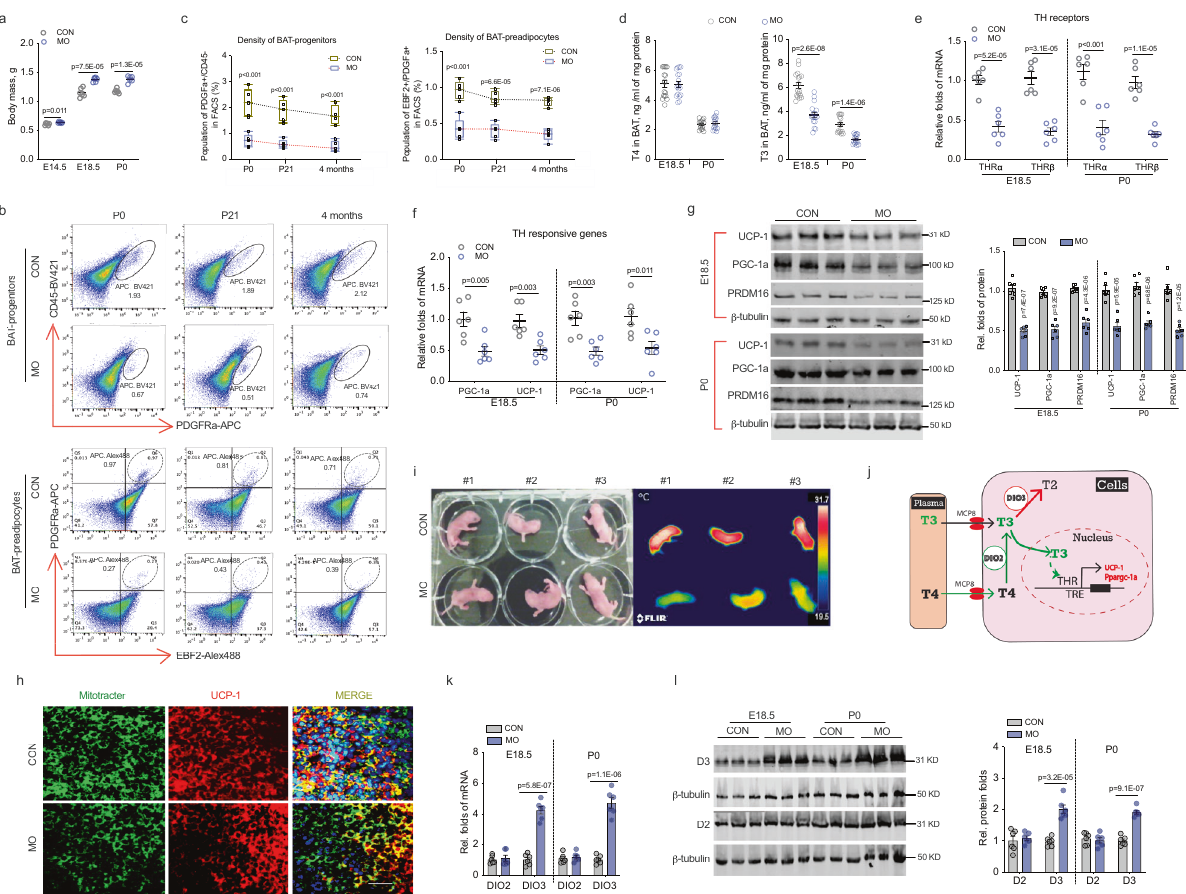
Fig. 3 Maternal obesity (MO) reduces T3 concentration and thyroid hormone signaling, linking to impaired brown adipogenesis with a fetal origin. a Fetal mass in control and obesity dam (MO) at 22 °C ( n = 6). b Density of brown progenitors (solid circle) and preadipocytes (dash circle) in female offspring BAT at P0, 21 days (weaning), and 4 months of age. FACS sorted brown progenitors and preadipocytes in BAT-stromal vascular fractions using brown progenitor marker Lin: CD45 − /PDGFRa + (in black solid circle) and brown preadipocyte marker Lin: EBF2 + /PDGFRa + (dash black circle in right side quarter). c Quanti fi ed brown progenitors and preadipocytes in BAT of female offspring ( n = 5). Whisker of box plots shows means and individual values from minimum to maximum. d Thyroid hormone (TH) thyroxine (T4) and triiodothyronine (T3) concentrations were analyzed in fetal and neonatal BAT at embryonic days E18.5 ( n = 15) and P0 ( n = 17). e , f mRNA expression of TH receptors TR α and TR β ( e ), and TH responsive genes Ppargc1a and Ucp- 1 ( f ) in fetal and neonatal BAT at E18.5 and P0 ( n = 6). mRNA expression was normalized to 18 S rRNA. g Immunoblotting measurements of PGC-1a, UCP- 1, and PRDM16 protein contents in fetal (E18.5) and neonatal BAT ( n = 6). β -tubulin was used as a loading control. h Immunostaining of mitochondrial (mito-tracker) and UCP-1 protein in neonatal BAT ( n = 4). Scale bar 100 µ m. i Thermal imaging of female neonates born to control and MO dam ( n = 14 in control; n = 11 in MO). Imaging was taken immediately after removing from cages to limit the effects of ambient temperature and heat loss. j Diagram illustrates TH uptake, T3 and T4, from blood circulation and bio-active conversion in brown adipocytes. TH membrane receptor MCP8 for TH uptake in brown adipocytes, TH responsive element (TRE), nuclear TH receptors (THR α and β ), iodothyronine deiodinases Dio2 and Dio3 , TH downstream thermogenic genes Ucp-1 , Ppargc1a . k mRNA expression of Dio2 and Dio3 in fetal and female neonatal BAT at E18 and P0 ( n = 6). mRNA expression was normalized to 18 S rRNA. l Protein contents of D2 and D3 were measured by immunoblotting; β -tubulin was used as a loading control ( n = 6). For data analyses, each pregnancy (dam) was considered as a replicate unit. Data are presented as mean ± s.e.m. Unpaired Student ’ s t test with two-tailed distribution was used in data